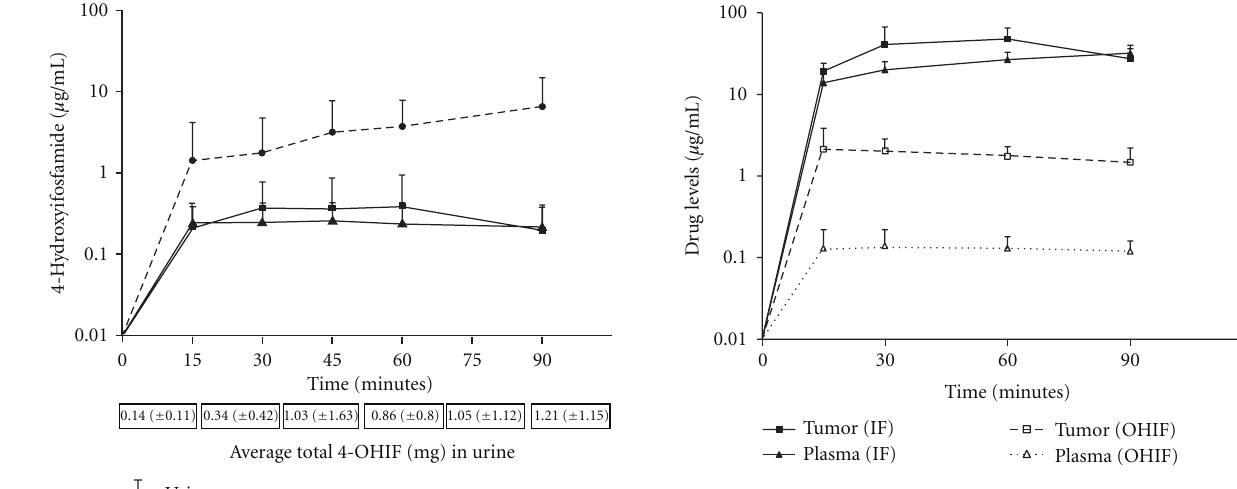
Figure 4: Comparison of ifosfamide and 4-hydroxyifosfamide con- centrations in tumor nodules and in